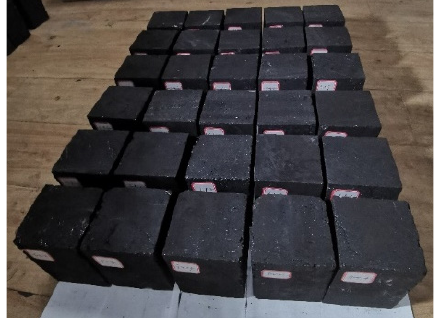
Figure 2. Coal samples used in the experiment.